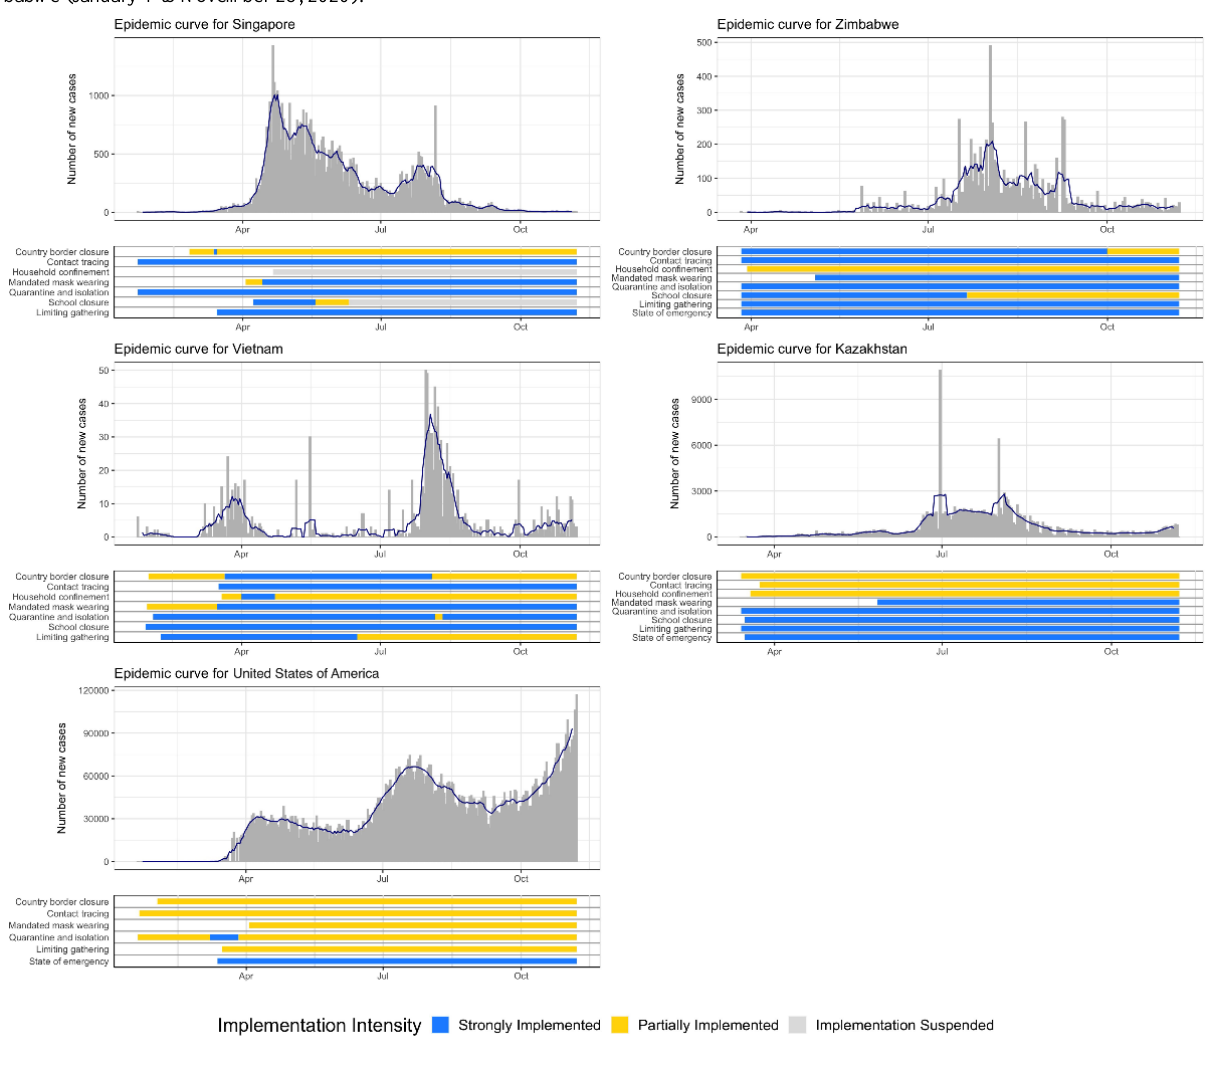
Figure 2. COVID-19 epidemic curves and public health and social measure timelines for Kazakhstan, Singapore, the United States, Vietnam, and Zimbabwe (January 1 to November 25,